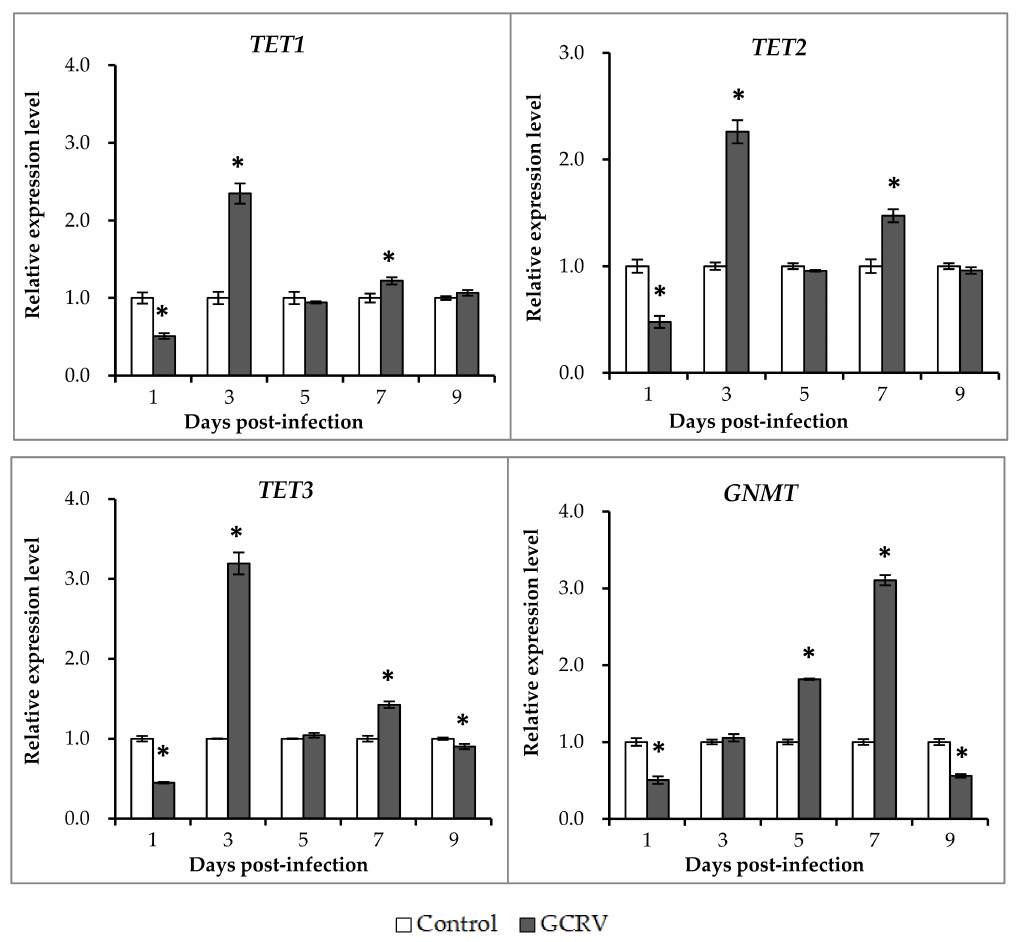
Figure 4. qRT-PCR analysis of the expression level of ten-eleven translocation proteins ( TET s) and glycine N-methyltransferase ( GNMT) after GCRV infection. The relative expression levels of genes were calculated as the ratio of gene expression levels in the GCRV-infected group relative to those in the control group at the same time-points. All data represent the mean ± standard deviation of three replicates ( n = 5 for each biological duplicate). Significant differences ( p < 0.05) in gene expression levels between the two groups are indicated with an asterisk